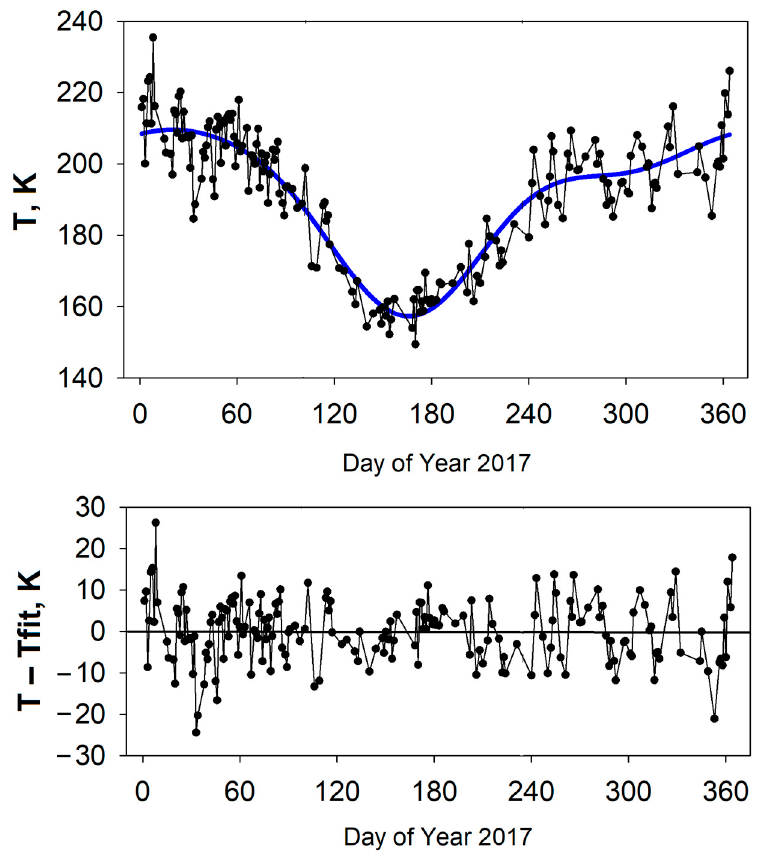
Figure 2. Upper panel: Seasonal variations in OH rotational temperature in the year 2017. Dots show nightly mean temperature. The solid blue line is a three-component harmonic fit to the measured data. Bottom panel: Differences of the measured data and the fit curve (residuals).